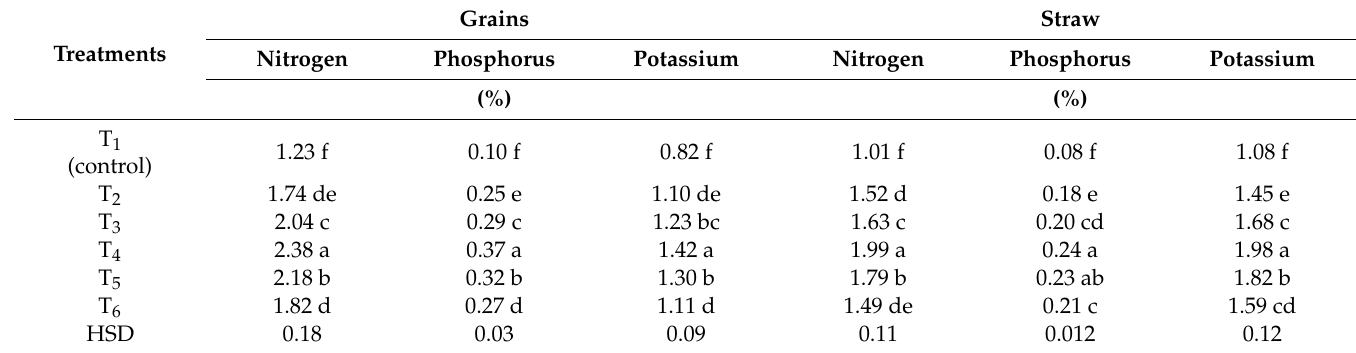
Table 2. E ff ect of polymer-bioaugmented PsJN coated DAP on nutrient concentration of wheat in a pot experiment. Grains Treatments